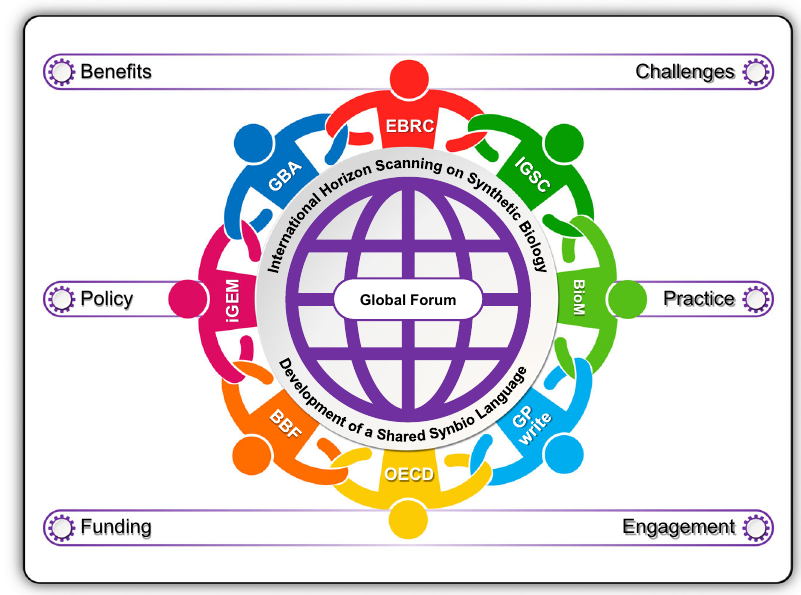
Fig. 2 A global forum on synthetic biology. Bringing together eight mature policy-practitioner communities that each share a synthetic biology focus will create a space where the discipline ’ s potential can be explored in a way that builds con fi dence across the international community. [Key: Engineering Biology Research Consortium (EBRC); Genome Project Write (GP write); International Gene Synthesis Consortium (IGSC); Global Biofoundry Alliance (GBA); iGEM Foundation (iGEM); BioBricks Foundation (BBF); Bioindustrial Manufacturing and Design Ecosystem (BioM); Organisation for Economic Co- operation and Development